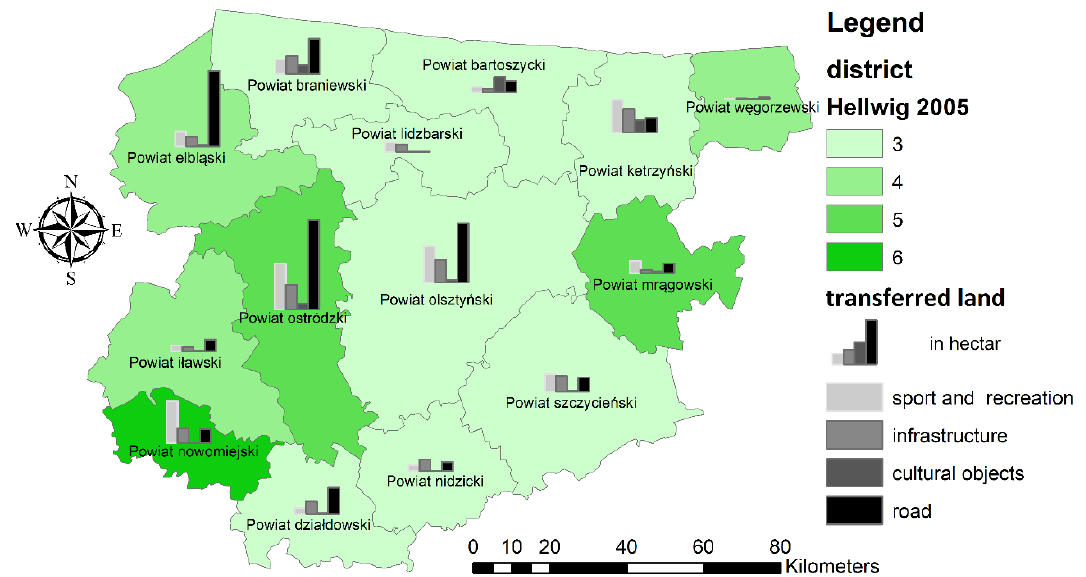
Figure 3. Area of transferred land, with the purpose of the transfer (communes) [in ha].